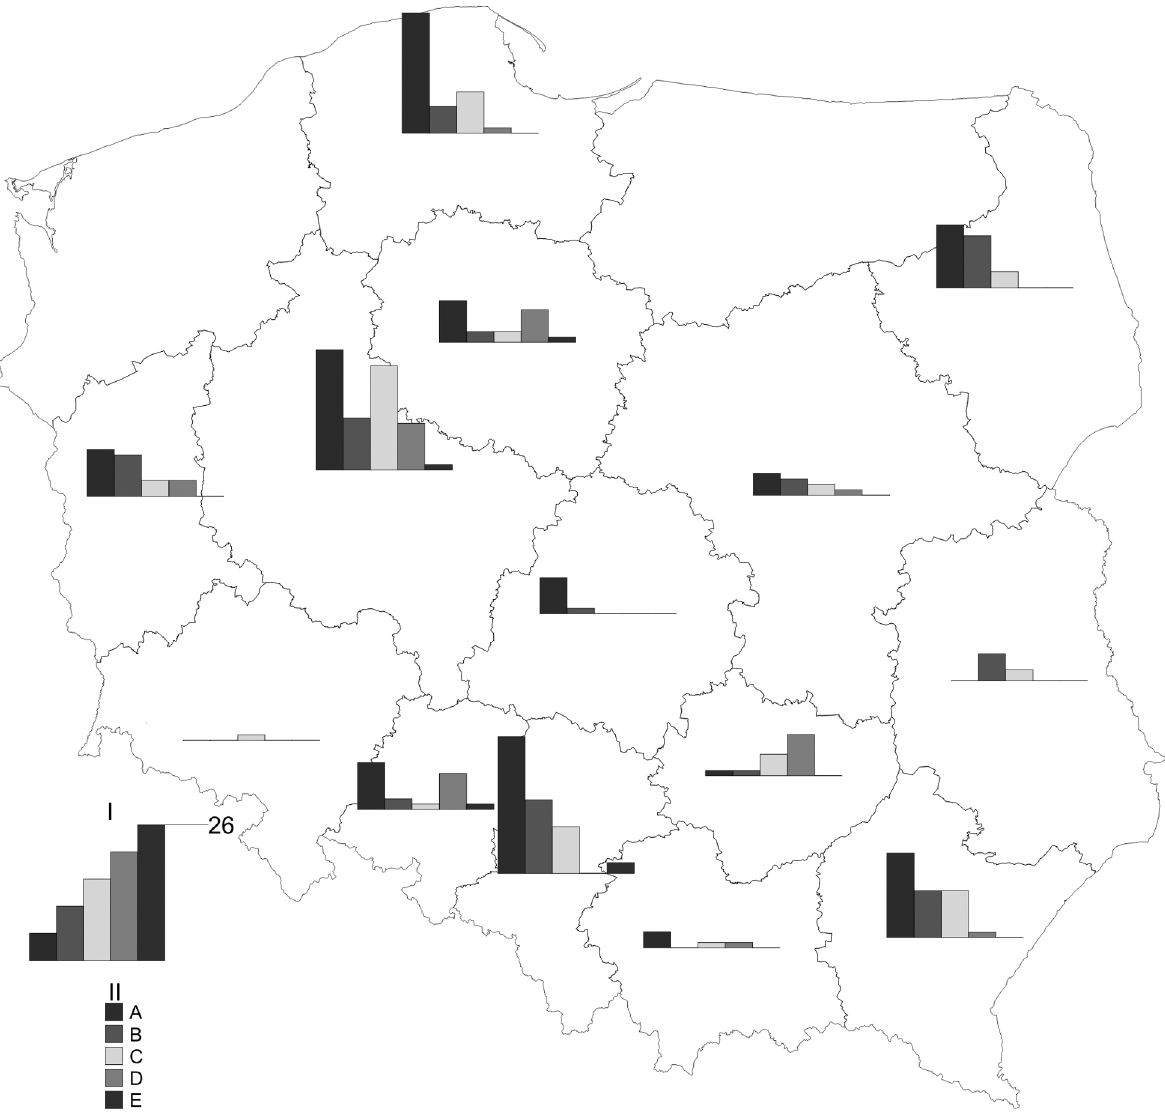
Fig. 6. Number and use structure of public buildings in Polish towns where TI projects were subsidised by the ROPV (2007–2013), as of 31 December 2012; by voivodeship. Explanation: I – number of public buildings; II – use structure of public buildings: A – educational establishments, B – health-care establish- ments, C – other public facilities (see note 1), D – public administration buildings, E – child-care establishments. Source: developed by the authors on the basis of data available on the European Funds